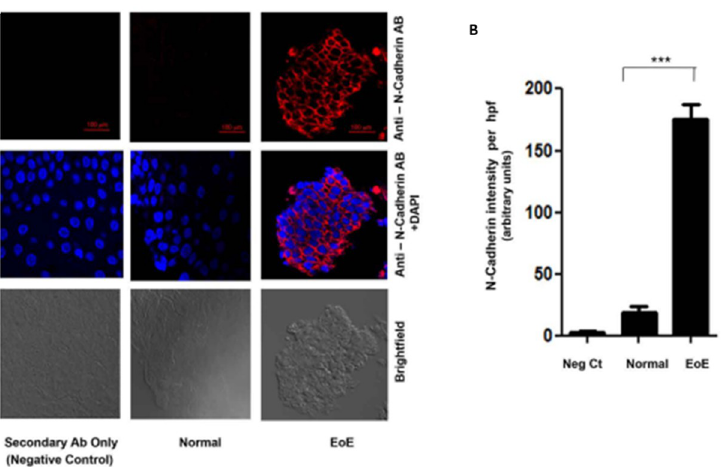
Fig 6. IF analysis of N-cadherin in esophageal tissue from pediatric control (0–5 Eos/HPF) and EoE patients ( > 15 Eos/HPF). A. Representative photomicrograph of immunostaining with anti-N-cadherin antibody. B . Densitometric analysis of N-Cadherin staining in EoE and control patient esophageal biopsy tissue. Values are representative of the mean of a sample size of 18 control and 18 patients with EoE. ��� P < 0.001.